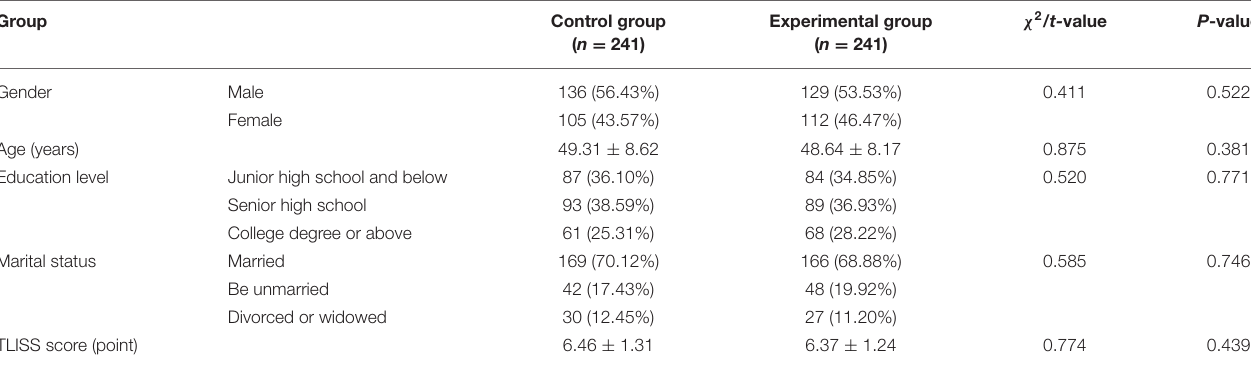
TABLE 1 | Baseline data of two groups ( n , %, x ±